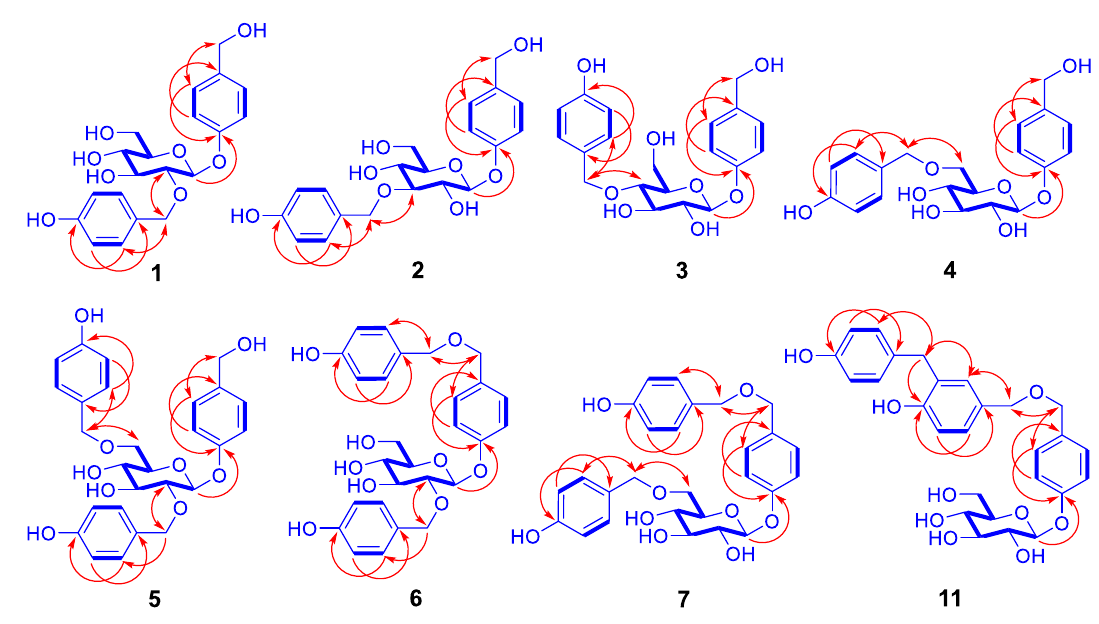
Fig. 2 Main 1 H- 1 H COSY (thick lines) and HMBC (arrows, from 1 H to 13 C) correlations of compounds 1 – 7 and